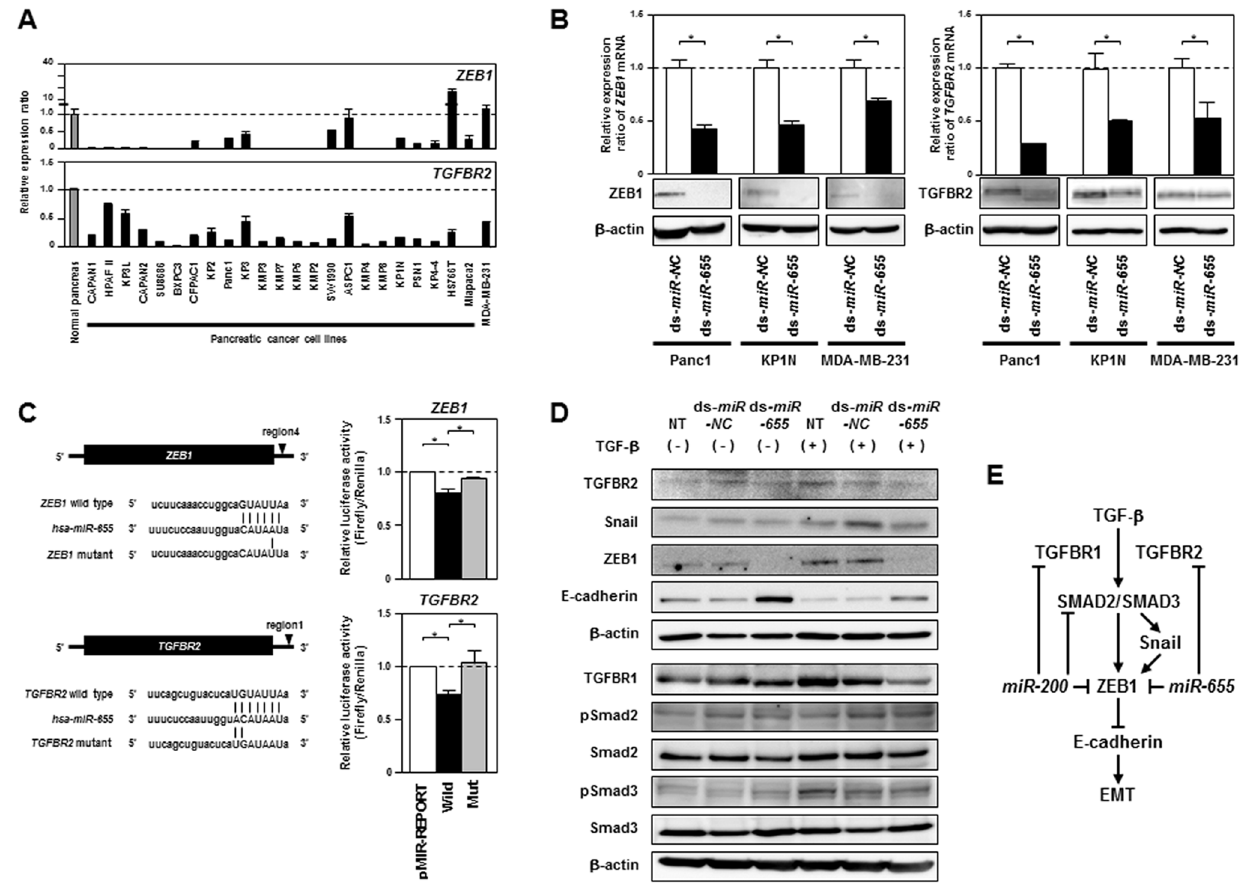
Figure 4. Characterization of ZEB1 and TGFBR2 as novel direct targets of miR-655 . A , Expression analysis for ZEB1 ( top ) and TGFBR2 ( bottom ) in a panel of 23 pancreatic cancer cell lines and a breast cancer cell line, MDA-MB-231, using TaqMan real-time RT-PCR. Relative expression levels of transcripts of ZEB1 and TGFBR2 were quantified in comparison to GAPDH to normalize the initial input of total RNA. Bar graphs show the ratio of the expression level in each cell line to that in a normal pancreas (Ambion). B , TaqMan real-time RT-PCR analysis and Western blot analysis of ZEB1 ( left ) and TGFBR2 ( right ) in Panc1, KP1N and MDA-MB-231 cells 96 hours after transfection with 10 nM of dsRNA mimicking miR-655 (ds- miR-655 ) or control non-specific miRNA (ds- NC ) (Ambion). C , Confirmation of ZEB1 and TGFBR2 as direct targets of miR-655 . Left , Schema of putative binding sites of miR- 655 in the 3 9 -UTR region of ZEB1 and TGFBR2 . Right , Results of luciferase reporter assays in Panc1 cells 48 hours after cotransfection of pMIR-REPORT luciferase vectors containing wild-type (Wt) or mutated (Mut) 3 9 -UTR target sites of ZEB1 or TGFBR2 for miR-655 , ds- miR-655 or ds- NC , and pRL-CMV internal control vector. These sites were analyzed using microRNA.org and Target Scan Human 6.2. D , Suppressive effects of ds- miR-655 on TGF-b- induced EMT in KP1N cells. The results of Western blotting of TGFBR2, Snail, ZEB1, E-cadherin, TGFBR1, Smad2/3 and phosphorylated Smad2/3 in KP1N cells 72 hours after treatment with or without TGF-b (5 ng/ml) and transfection with ds- miR-655 or ds- NC , simultaneously. TGF-b-treated cells were compared with untreated cells. E , Schema of regulation of the ZEB1-E-cadherin axis and TGF-b signaling pathway by miR-655 through downregulation of ZEB1 or TGFBR2 in cancer cells.